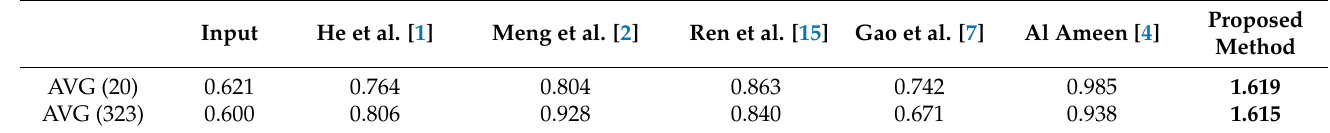
Table 10. The comparison of the UIQM [34] average scores on the sample images (Figures 6 and 7) and DWAN dataset [32] (If the score is high, the image is enhanced well. The highest scores are indicated in bold